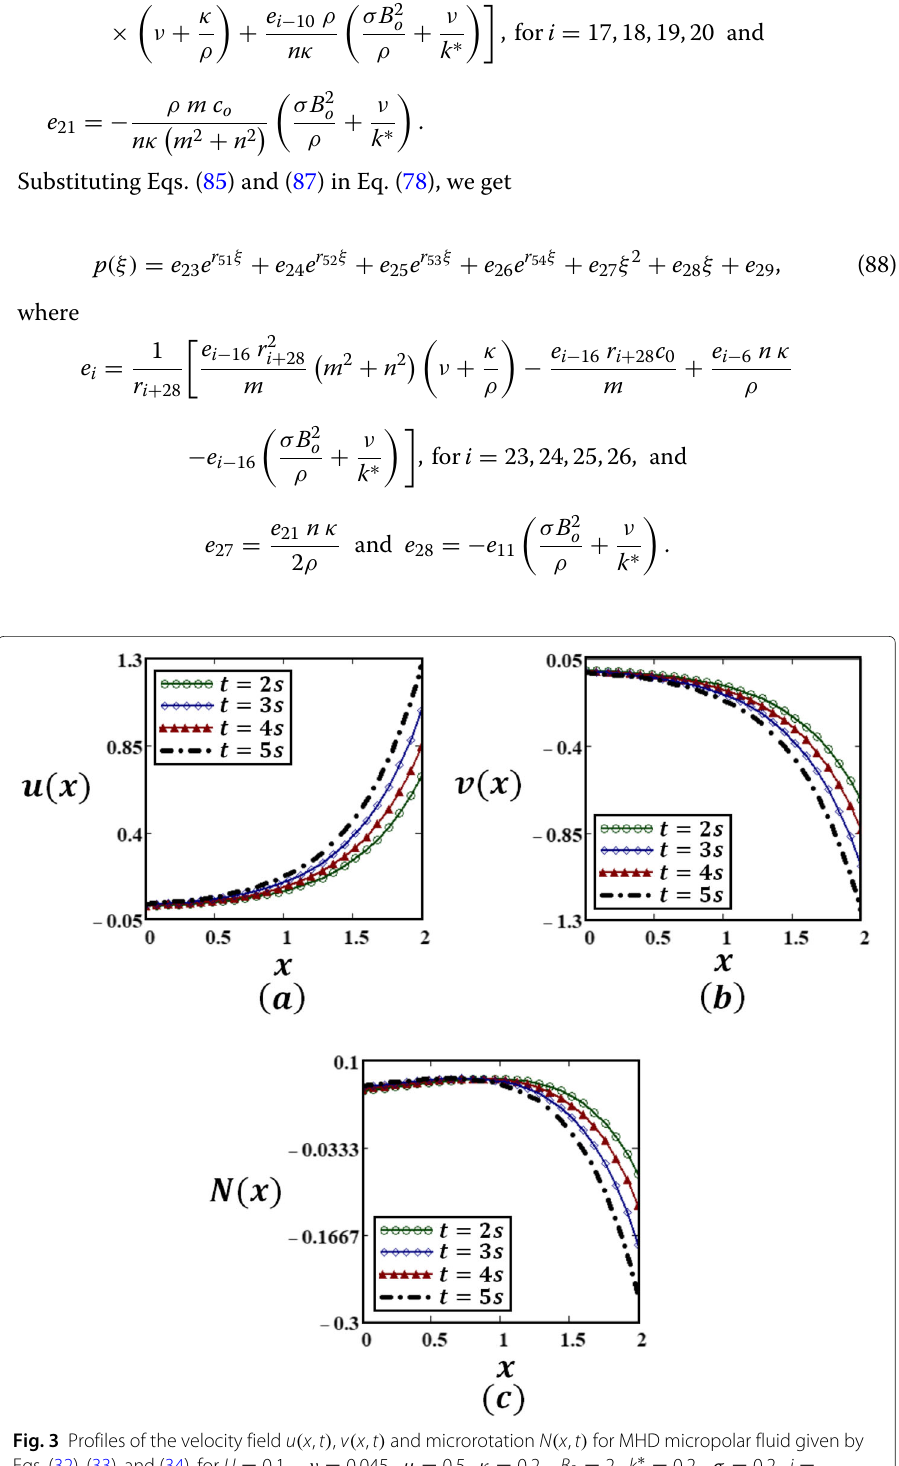
Fig. 3 Profiles of the velocity field u ( x , t ) , v ( x , t ) and microrotation N ( x , t ) for MHD micropolar fluid given by Eqs. (32), (33), and (34), for U = 0.1, ν = 0.045, μ = 0.5, κ = 0.2, B 0 = 2, k ∗ = 0.2, σ = 0.2, j = 0.03, m = n = 1, y = 1, c 0 = 0.01, and different values of